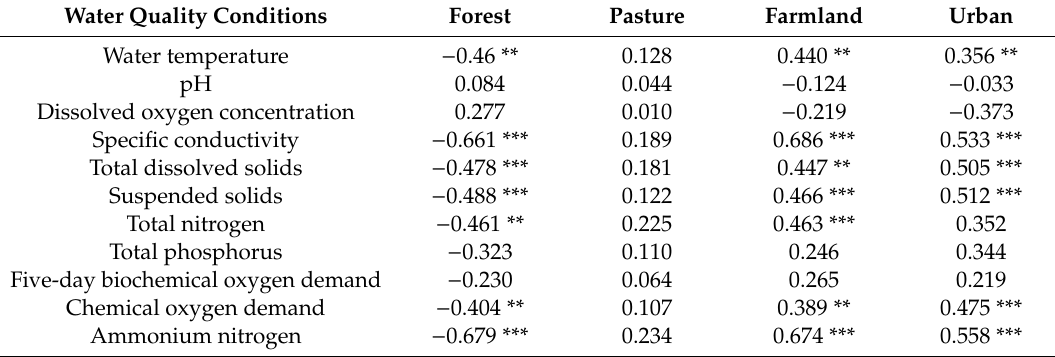
Table 2. The Spearman’s correlation coe ffi cients between land use types and local water quality conditions. (* ( p < 0.05), ** ( p < 0.01), or *** ( p < 0.001) indicates the significance level as performed by the Bonferroni